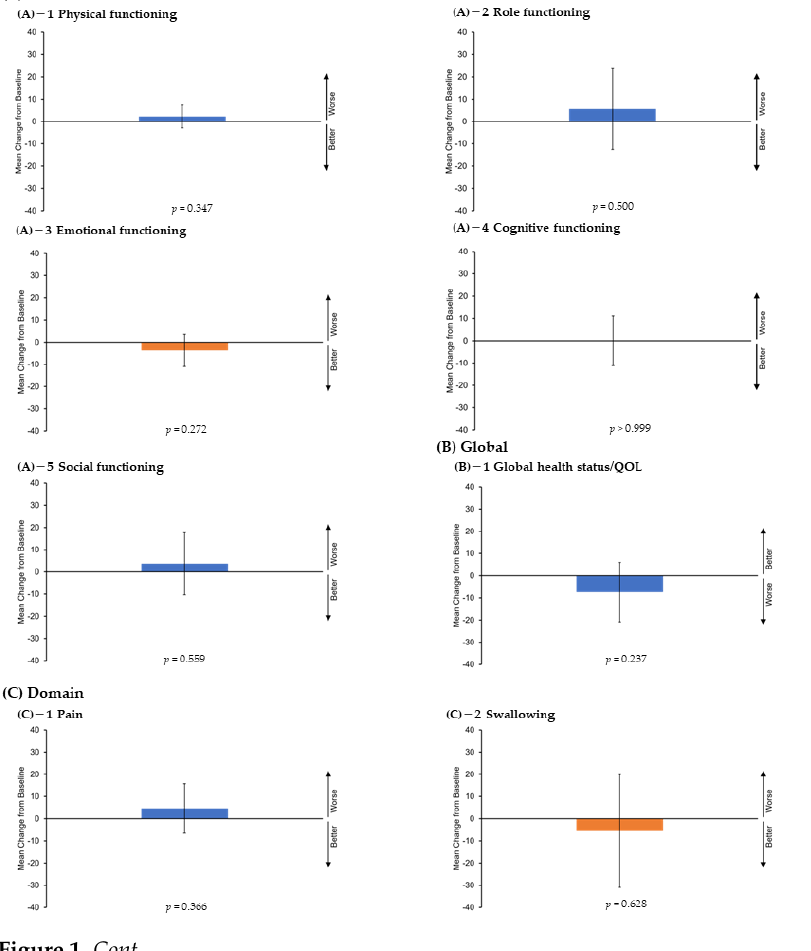
Figure 1. Quality of life assessments. ( A ) Functional scales (physical, role, emotional, cognitive, and social activities) and ( B ) global health status were assessed using the EORTC QLQ-C30. ( C ) Domain scales (pain, swallowing, sense problems, speech problems, trouble with social eating, trouble with